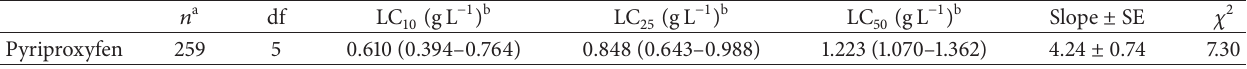
Table 1: Toxicity of pyriproxyfen on the 3rd instar larvae of diamondback moth, Plutella xylostella